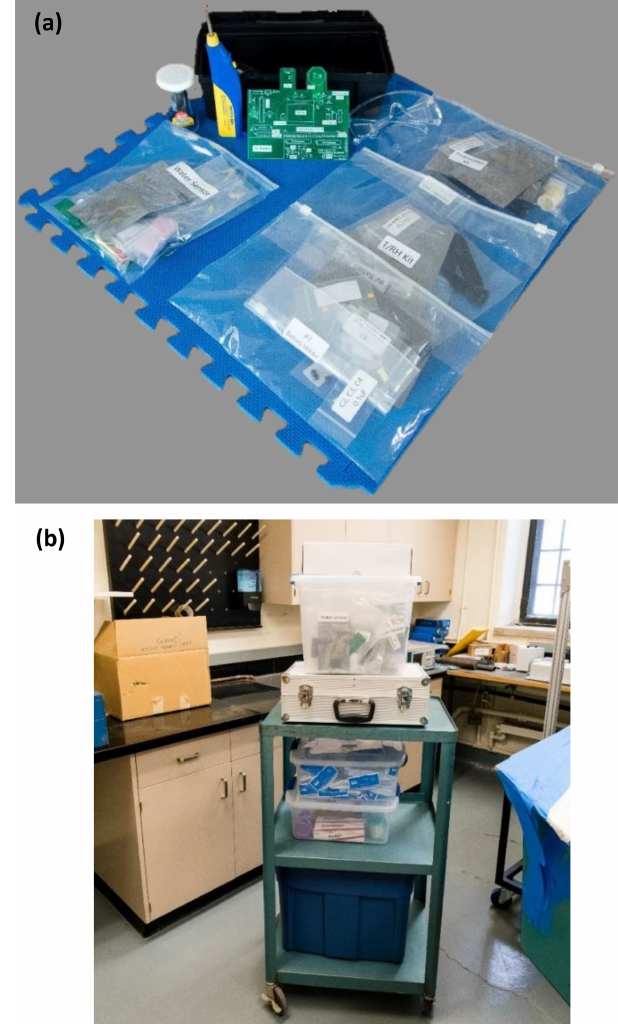
Figure 3. (a) The circuit components were individually bagged and labelled for student assembly. Also visible in this image is the battery-operated soldering iron used by students for soldering, a toolbox containing hand tools for assembly and a glue bottle used to glue on the diffuser to the circuit board to cover the photodiode for creation of a pyranometer to measure shortwave radiation from the sun. (b) Image showing containers used to transport the kits to a